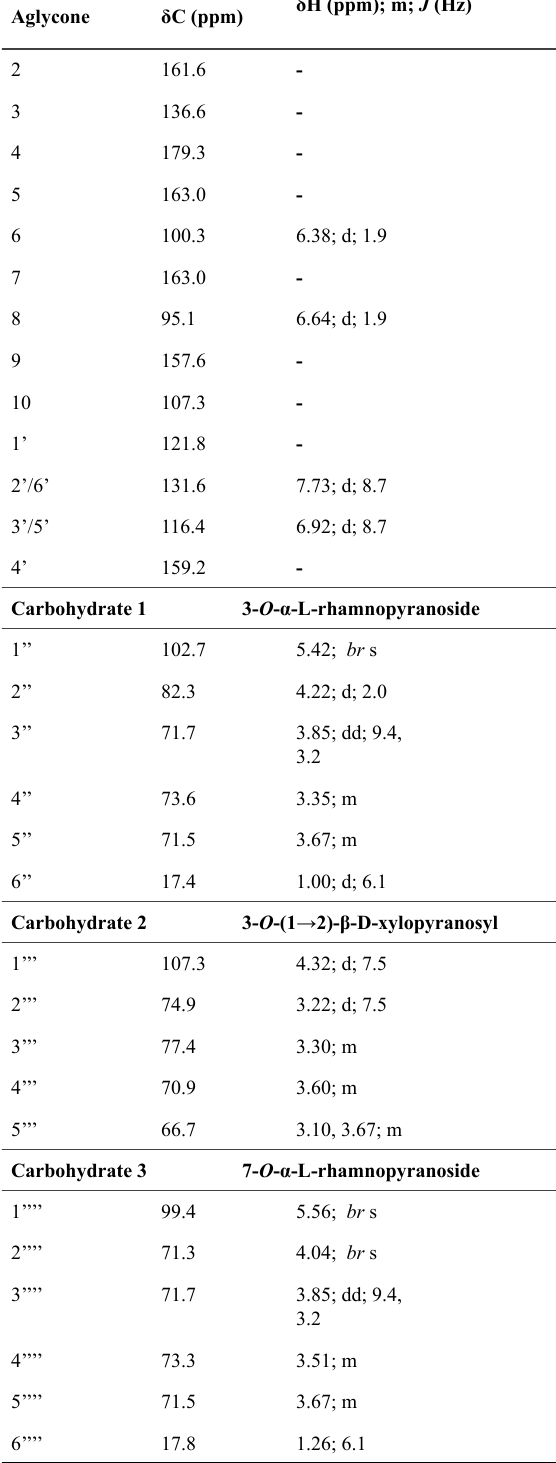
Table S1: 1 H NMR data (300 MHz), 13 C (75 MHz) observed for sagittatin A (CD 3 OD).